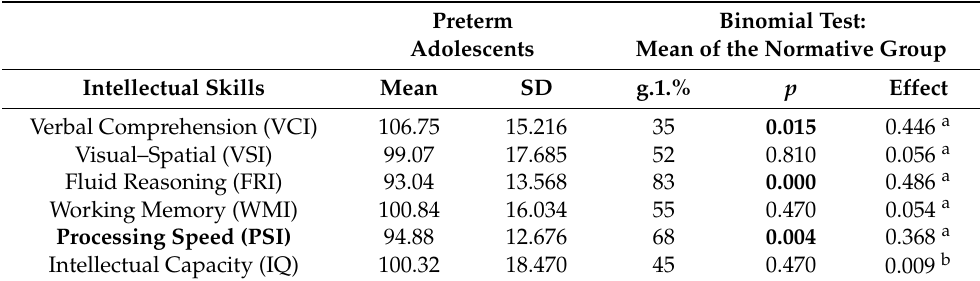
Table 1. Comparison of the average of the composite scores of intellectual skills in adolescents born prematurely and normative group